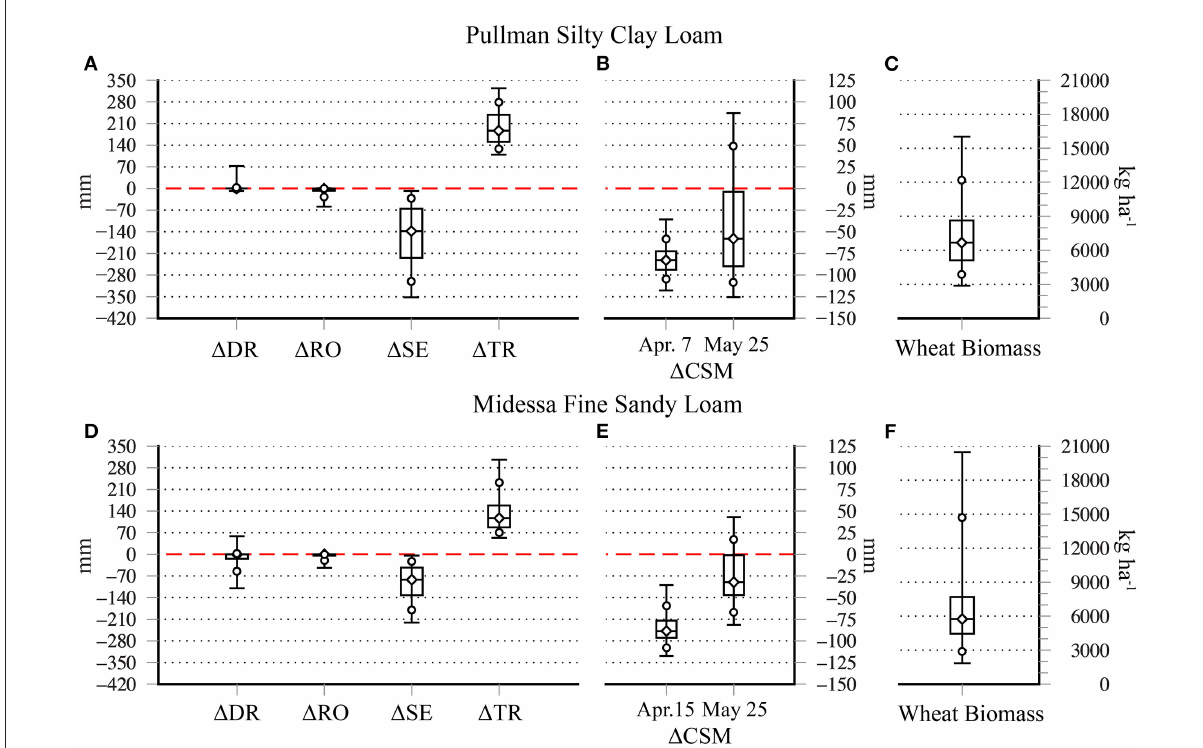
FIGURE5 (A) Distributions of MO 17 WHCO-FACO management effects on cumulative drainage ( 1 DR), runoff ( 1 RO), surface evaporation ( 1 SE), and transpiration ( 1 TR) during simulation start to cotton planting for the PSCL soil. (B) Distributions of column soil moisture effects ( 1 CSM) at MO 17 wheat termination (Apr. 7) and cotton planting (May 25) dates. (C) Distribution of MO 17 wheat biomass (WBIO) outcomes. (D) Distributions of MO 18 WHCO-FACO management effects on cumulative drainage ( 1 DR), runoff ( 1 RO), surface evaporation ( 1 SE), and transpiration ( 1 TR) during simulation start to cotton planting for the MFSL soil. (E) Distributions of column soil moisture effects ( 1 CSM) at MO 18 wheat termination (Apr. 15) and cotton planting (May 25) dates. (F) Distribution of MO 18 wheat biomass (WBTO) outcomes.